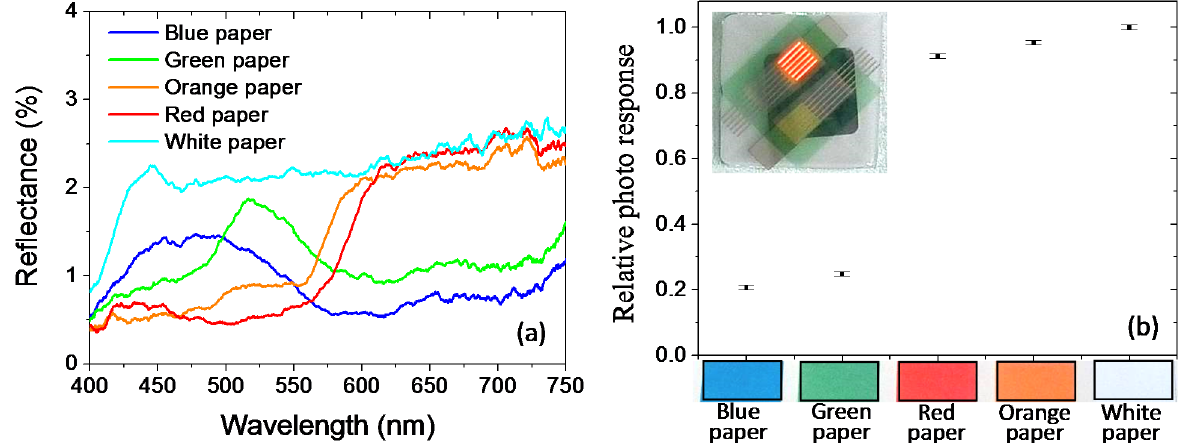
Figure 6. ( a ) The reflection spectra measured for the different reflection surfaces of white paper, orange paper, red paper, green paper, and blue paper; ( b ) Normalized photo responses of the organic optical sensor measured for different colored paper placed underneath the